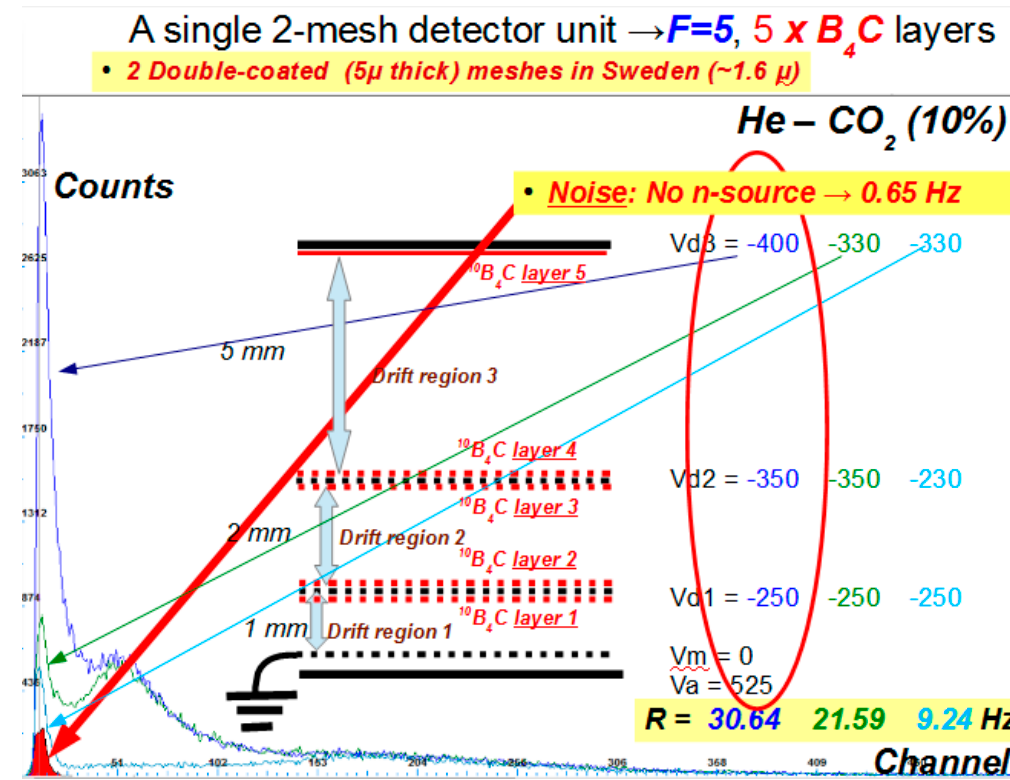
Figure 4 . Data measured during 3000 s for each run, using a single two-mesh detector unit equipped with five layers of 10 B 4 C [11].